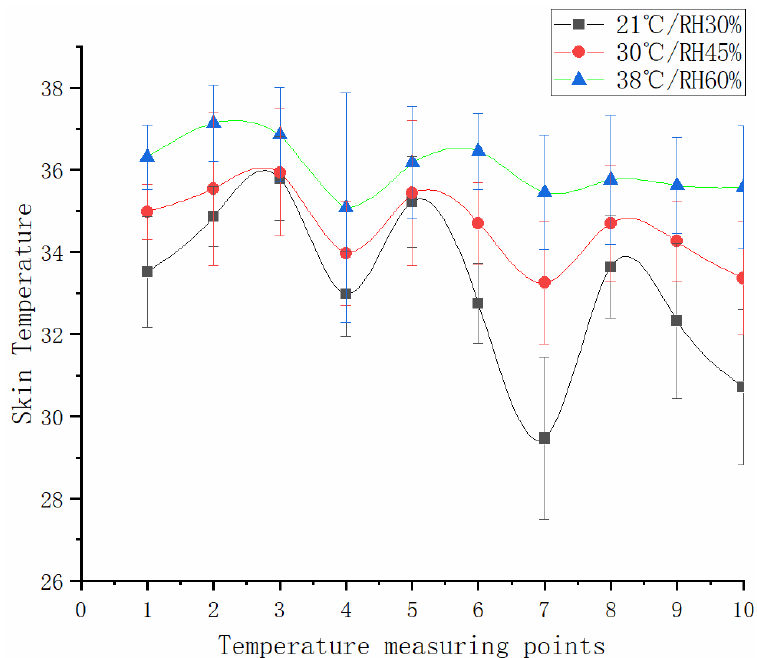
Figure 5. Mean skin temperature changes at various measuring points, where points 1–10 represent of the head, left upper arm, and chest, back, abdomen, left lower arm, left hand, left thigh, left calf, and left foot.